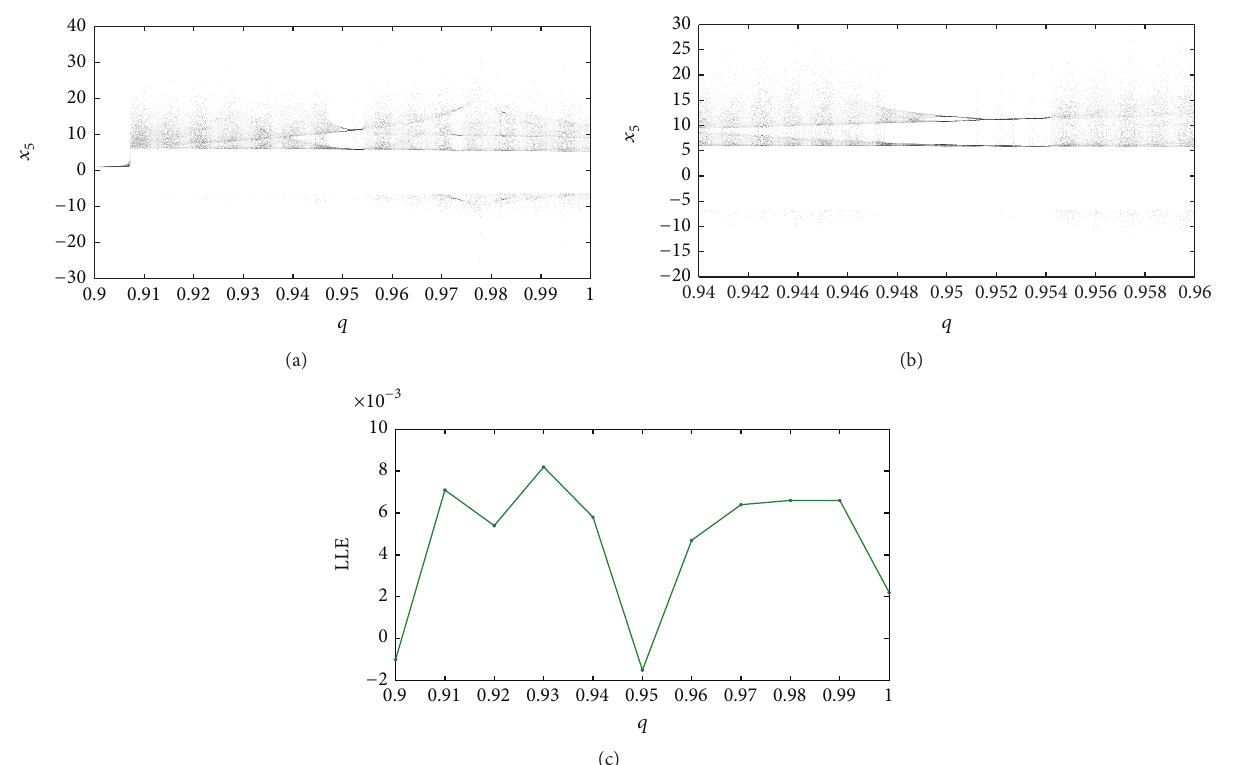
Figure 6: The bifurcation diagram of the system (14) with derivative order 𝑞 . (a) 𝑞 ∈ [0.9, 1] ; (b) local zoom of (a); (c) the corresponding LLE